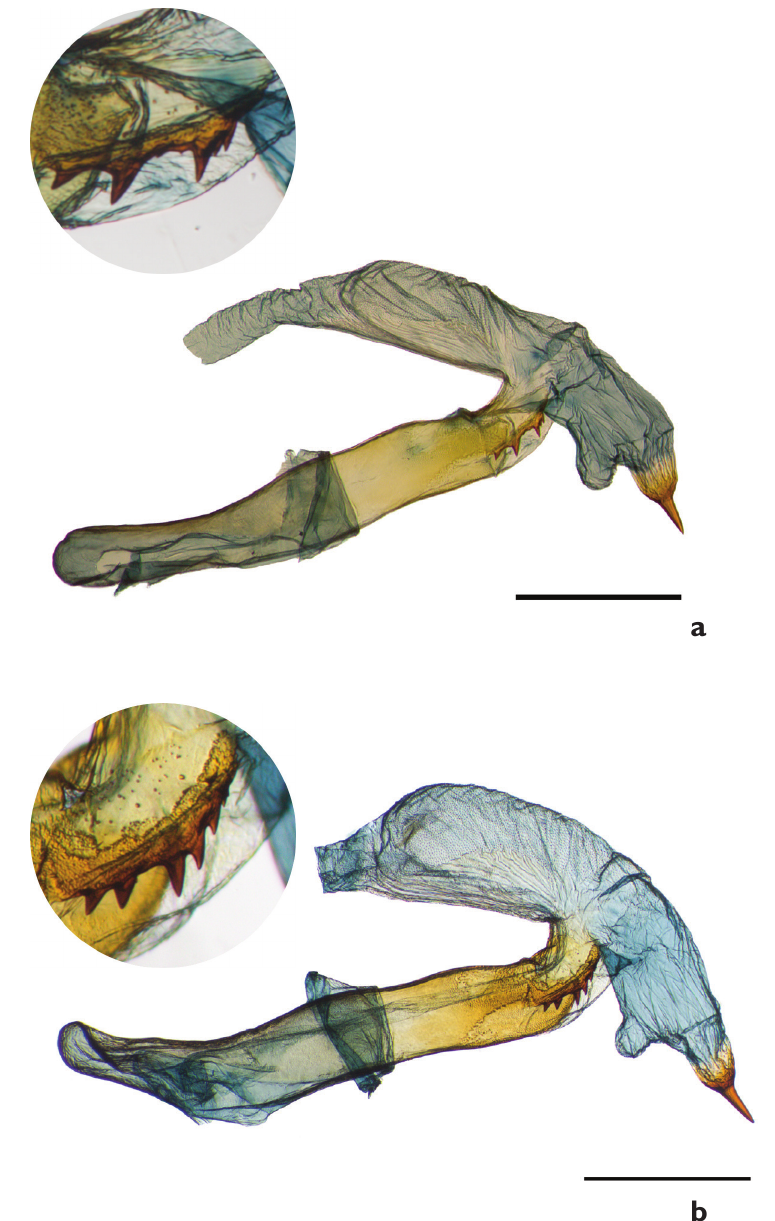
Figure 23. Everted vesica of Abagrotis benjamini , Aquinnah, MA. a USNM dissection #148029 b Evert- ed vesica of Abagrotis benjamini , Dartmouth, MA. USNM dissection #148067. Cf. Figs 9d (larva), 11(adult), and 18a, b